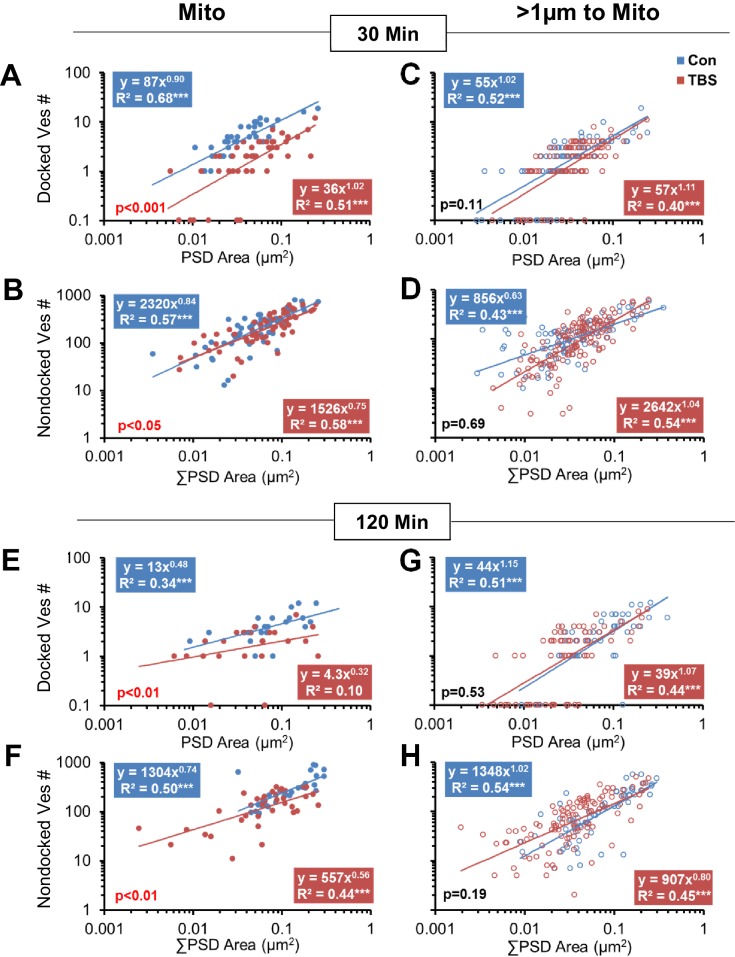
Effect of synapse size and mitochondrial presence on vesicle mobilization following TBS at P15.Synapses with mitochondria located among the presynaptic vesicles (Mito) were compared to those without mitochondria (>1 µm to Mito). At 30 min following TBS, boutons with mitochondria had (A) fewer docked vesicles (F1,81 = 61.4, p<0.001) and (B) fewer nondocked vesicles (F1,108 = 5.03, p=0.021) relative to control conditions. In contrast, boutons with no mitochondria showed no significant differences in (C) docked (F1,169 = 2.64, p=0.11) or (D) nondocked vesicles (F1,227 = 0.17, p=0.69) between TBS and control conditions at 30 min. Furthermore, under control conditions, (A) fewer boutons with mitochondria had zero docked vesicles than (B) boutons with no mitochondria (F; F1,107 = 3.87, p<0.05), but this mitochondria-related difference (F1,145 = 0.57, p=0.45) did not hold in the TBS condition. At 120 min following TBS, boutons with mitochondria had (E) fewer docked (F1,44 = 12.4, p=0.001008) and (F) fewer nondocked vesicles (F1,63 = 7.84, p=0.007) relative to control conditions across the distribution of synapse sizes. In contrast, boutons with no mitochondria showed no significant differences between the TBS and control conditions in the number of (G) docked vesicles (F1,116 = 0.41, p=0.53) or (H) nondocked vesicles (F1,169 = 1.71, p=0.19). Furthermore, fewer boutons (E) with mitochondria lacked docked vesicles than those (F) without mitochondria (F1,92 = 4.2, p<0.05) at 120 min following TBS, whereas this difference did not reach significance under the control conditions (F1,72 = 3.01, p=0.08). In addition, (G) more of the boutons without mitochondria lacked docked vesicles at 120 min after TBS than under control conditions (F1,118 = 4.9, p<0.05). The x-axis represents individual PSD areas for docked vesicles (A, C, E, G) and summed PSD area for nondocked vesicles to account for MSBs (B, D, F, H). The results of the ANCOVAs are indicated in the lower left corner of each graph, whereas the results from ANOVAs concerning the differences among conditions for boutons lacking docked vesicles are summarized in this figure legend.